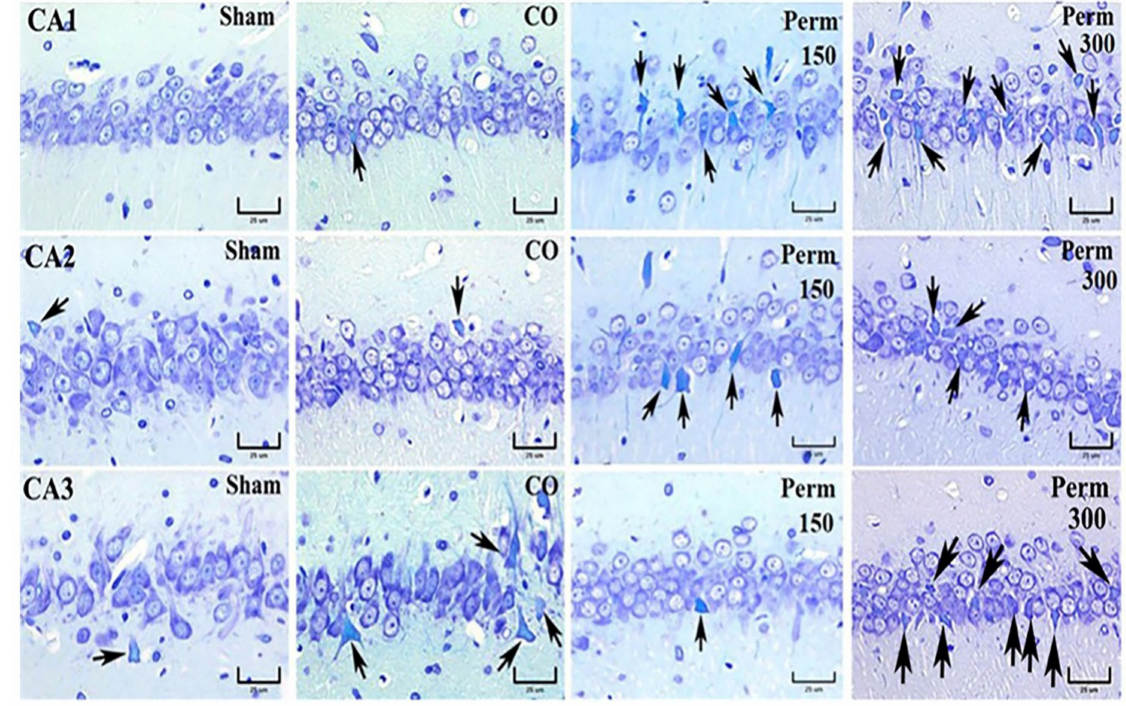
Figure 5. Photomicrographs of the hippocampal CA1, CA2 and CA3 of sham rats, rats treated with corn oil (CO) and rats treated with 150 and 300 mg/kg of permethrin. Arrows indicate neurons with histopathological features of cell degeneration or death. Klüver-Barrera